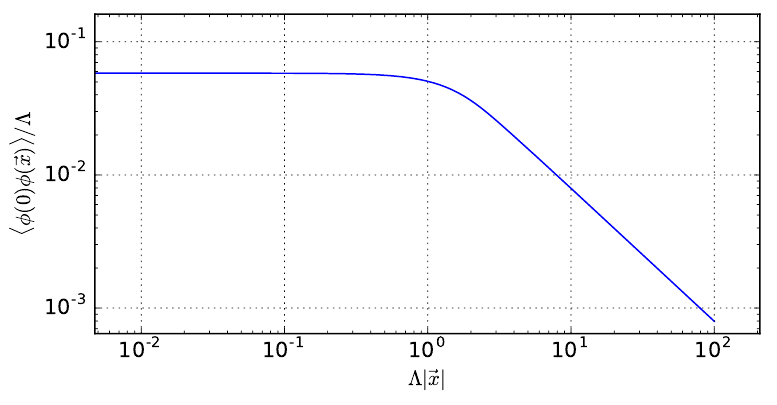
Figure 8 . h (cid:30) (0) (cid:30) ( ~x ) i correlator computed for the 2+1-dimensional bosonic cMERA.